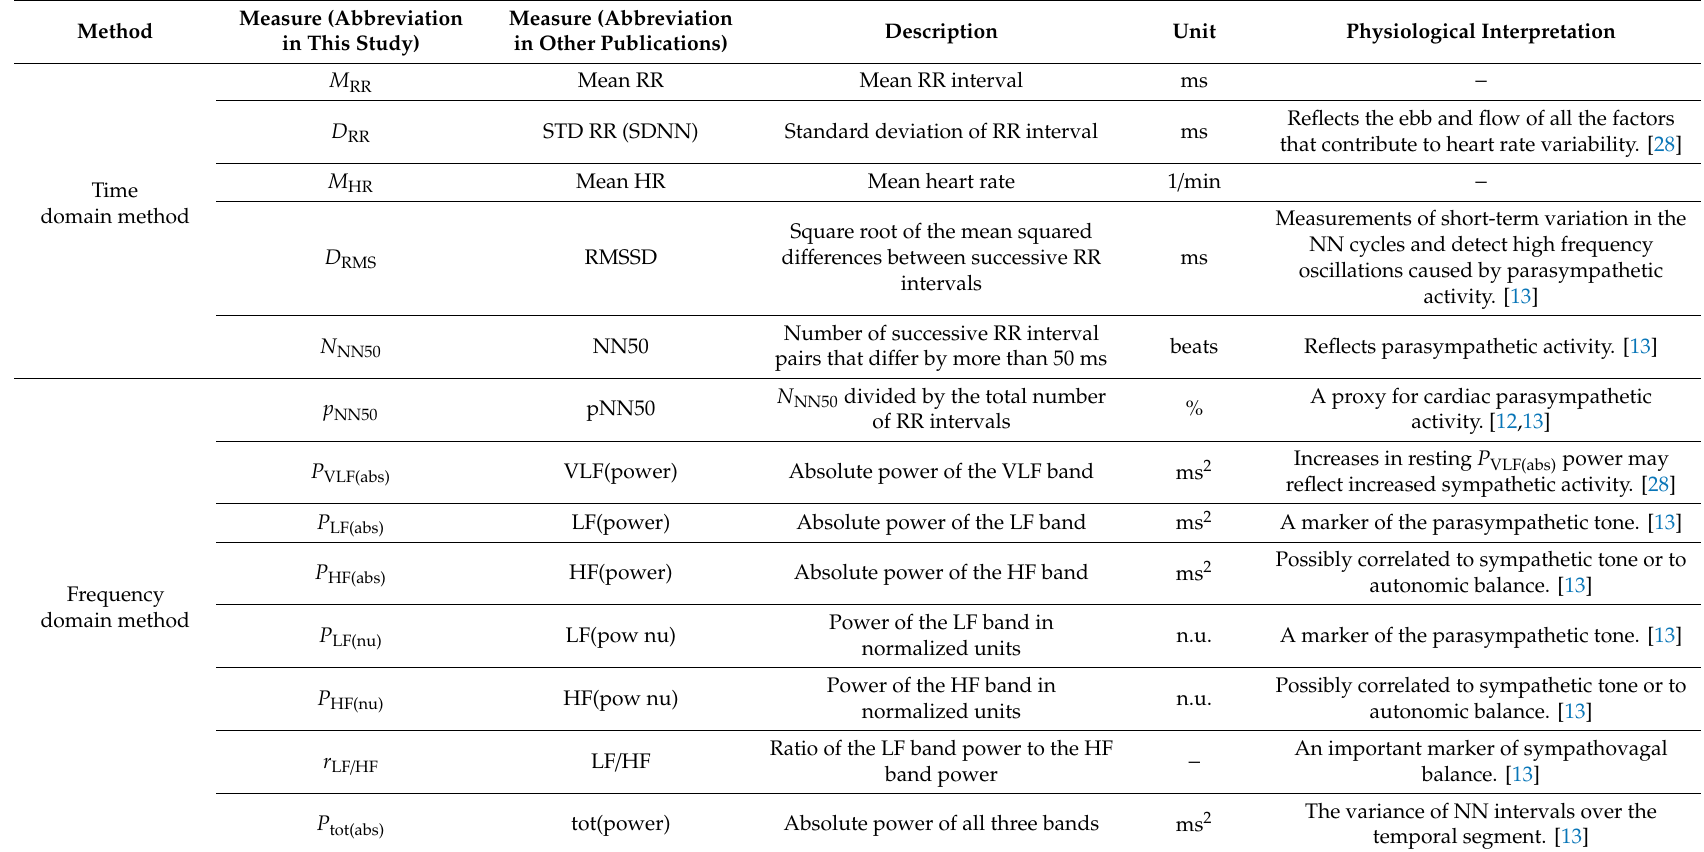
Table 3. Overview of the HRV time and frequency domain